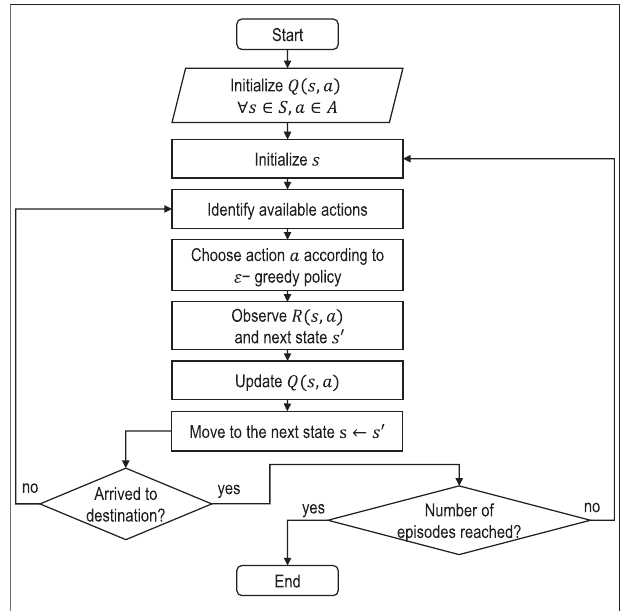
FIGURE 2 | One-step ahead Q-learning